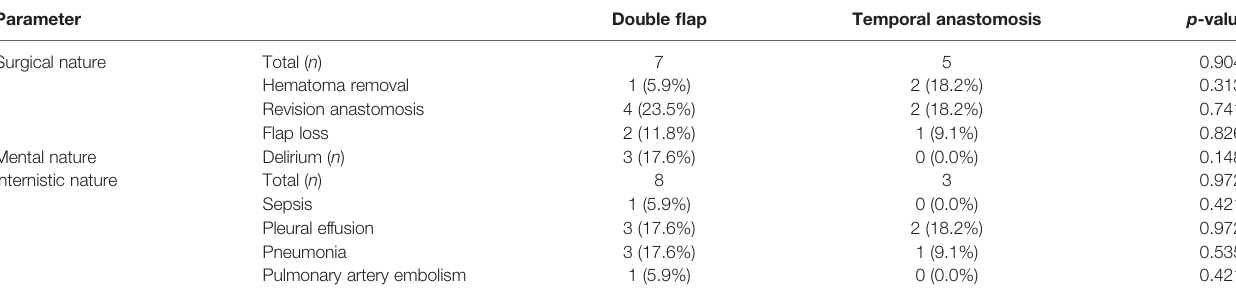
TABLE 5 | Group-related complications: double fl ap versus temporal anastomosis. .